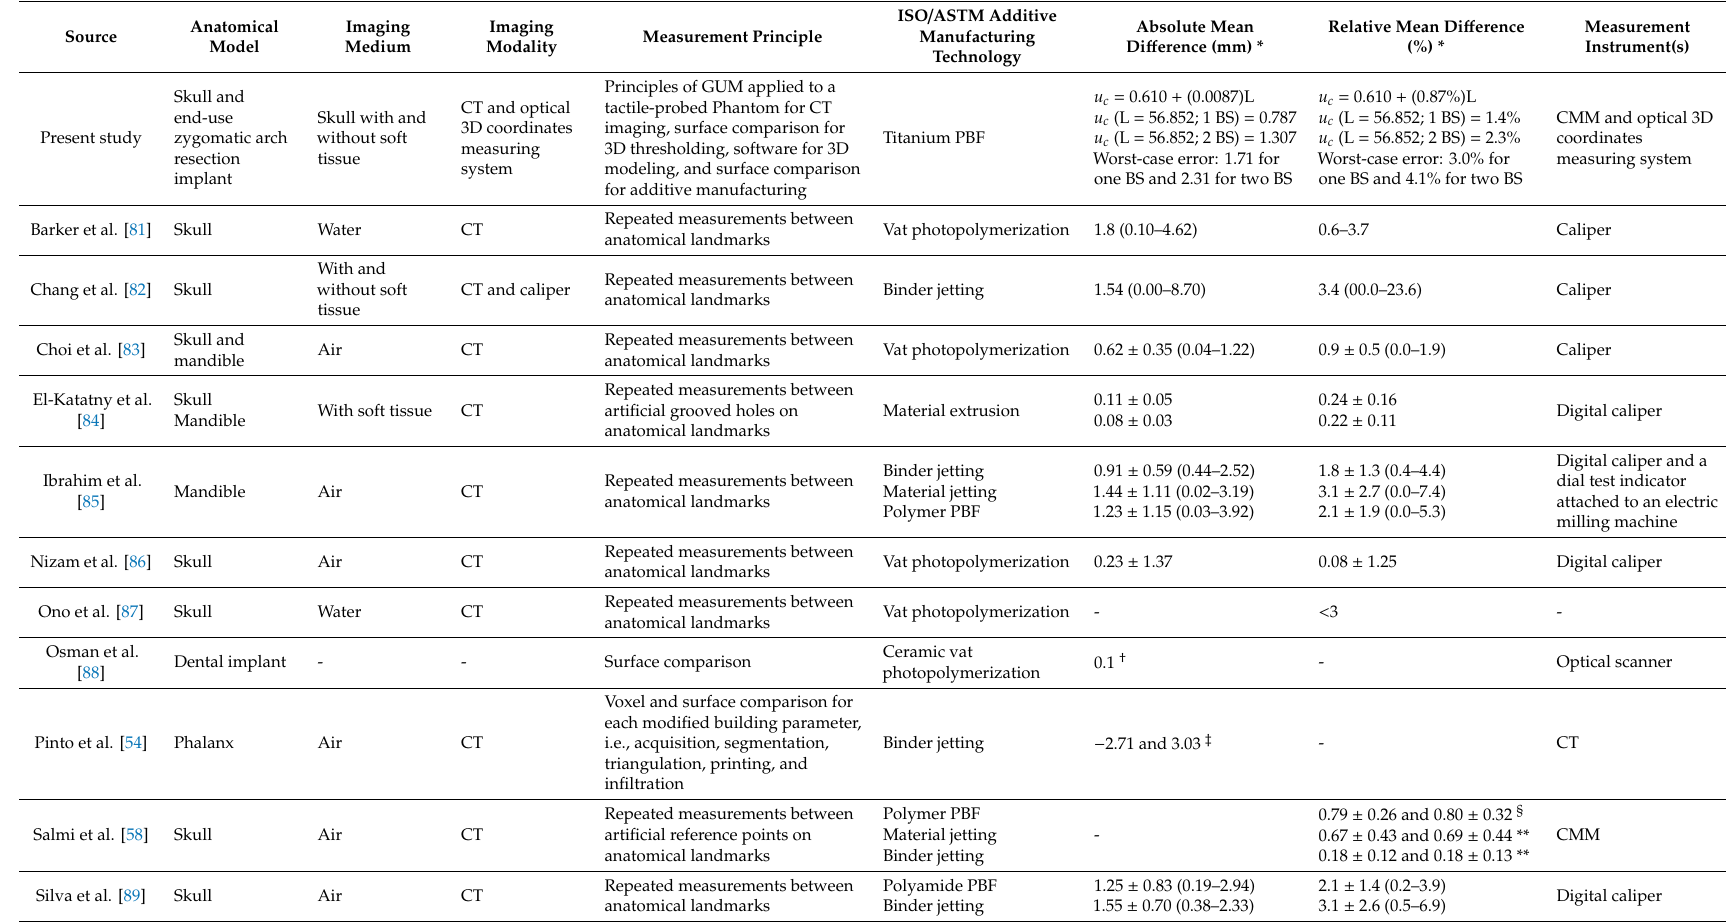
Table 10. Cumulative error analysis of this study compared with